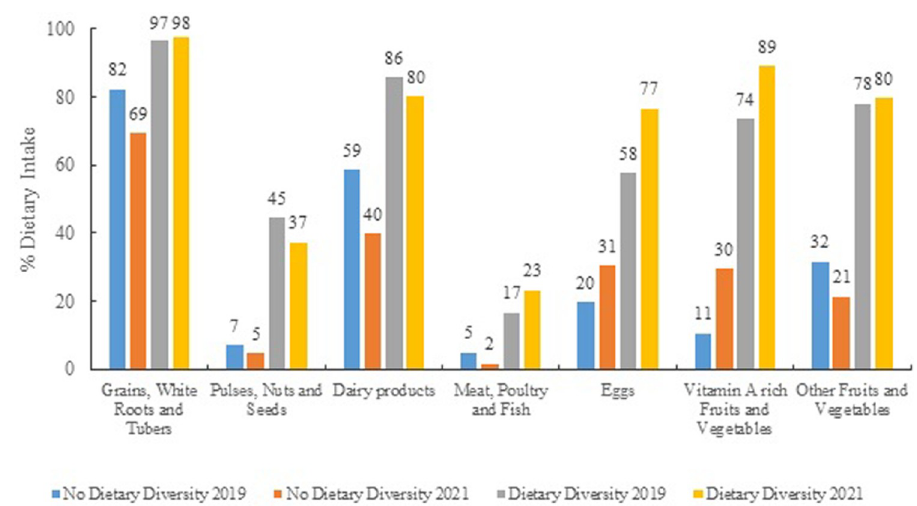
Fig 1. Dietary intake among children (6–23 months) across food groups by their dietary diversity status, Gadchiroli and Chandrapur, 2019 and 2021.